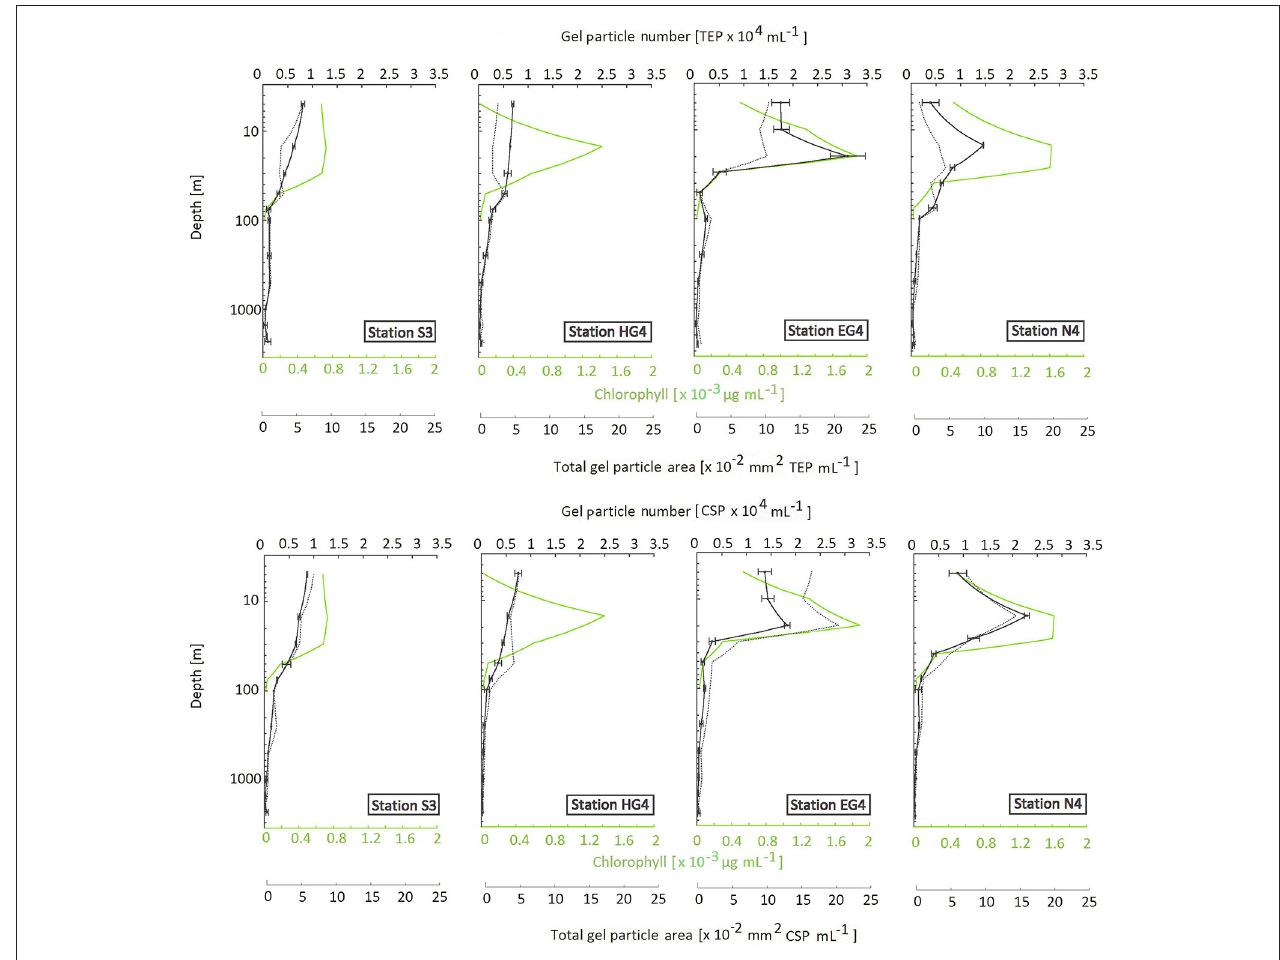
FIGURE 2 | Vertical profiles of gel particle number (black line with errorbars that represent standard deviation of the two replicates), total gel particle area (dashed line; interpolated between sample depths) and chlorophyll a (green line). Y-axis inverse, with logarithmic scaling.